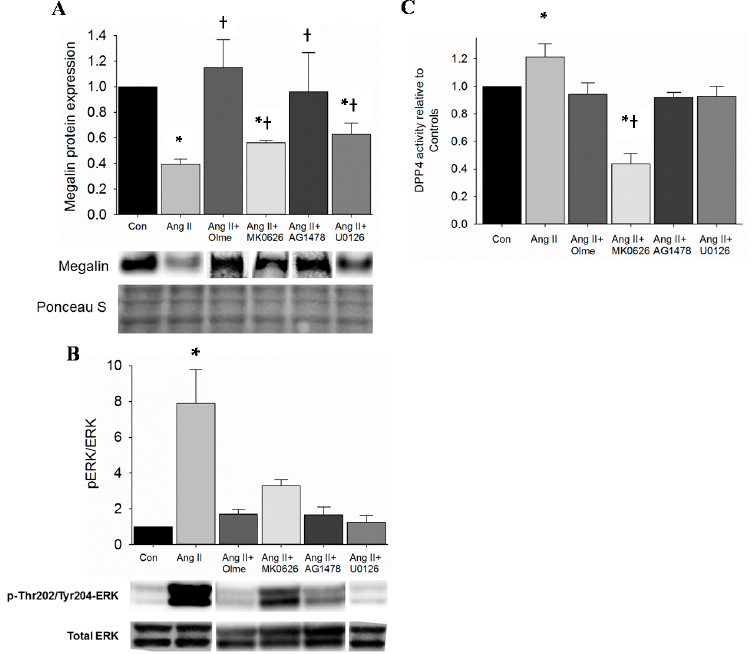
Figure 3 . Ang II regulates megalin protein expression via DPP4 activation. ( A ) Megalin protein expression by immunoblot in T35OK-AT 1 R proximal tubule cells. Proximal tubule cells were stimulated with Ang II (10 − 8 M) for 24 h and pre-treated 1 h with olmesartan (10 − 6 M), AG1478 (10 − 5 M), U0126 (10 − 5 M) and MK0626 (5 × 10 − 5 M); ( B ) ERK1/2 activation was assessed by pThr 202 Tyr 204 -ERK1/2 increase. Proximal tubule cells were stimulated with Ang II (10 − 8 M) for 30 min and the ratio of pThr 202 Tyr 204 -ERK1/2 to total ERK1/2 ratio was calculated. Proximal tubule cells were pre-treated for 1 h with olmesartan (10 − 6 M), AG1478 (10 − 5 M), U0126 (10 − 5 M) and MK0626 (5 × 10 − 5 M); ( C ) DPP4 activity in conditions of chronic Ang II stimulation. T35OK-AT 1 R proximal tubule cells were stimulated for 24 h with Ang II (10 − 8 M) and olmesartan (10 − 6 M), AG1478 (10 − 5 M), U0126 (10 − 5 M) and MK0626 (5 × 10 − 5 M) were tested for blockade of Ang II-mediated increase in DPP4 activity. n = 3–6; * p < 0.05 when compared to control; † p < 0.05 when compared to Ang II.